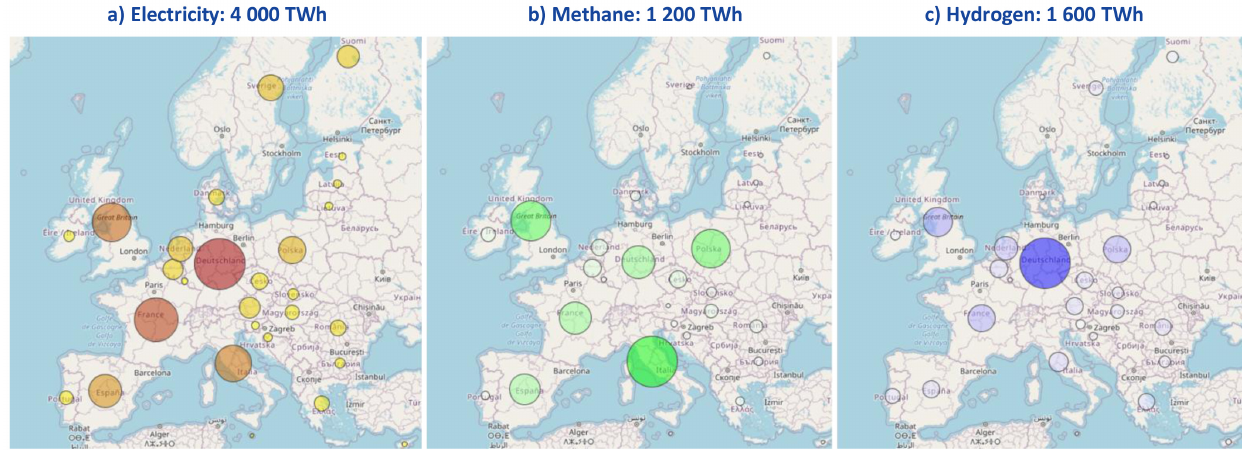
Figure 2. Final energy demand breakdown in the reference